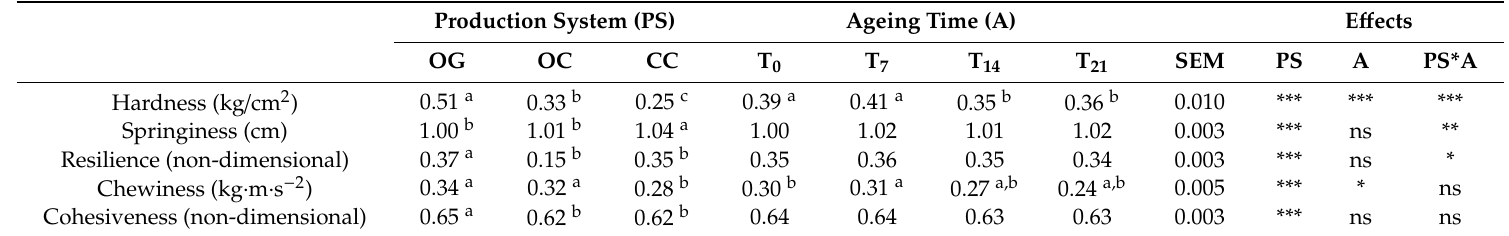
Table 2. E ff ect of the production systems and ageing time (T 0 , T 7 , T 14 , and T 21 : 0, 7, 14, and 21 days, respectively) on texture profile analysis 20% (TPA20) of Longissimus thoracis from calves of the Retinta